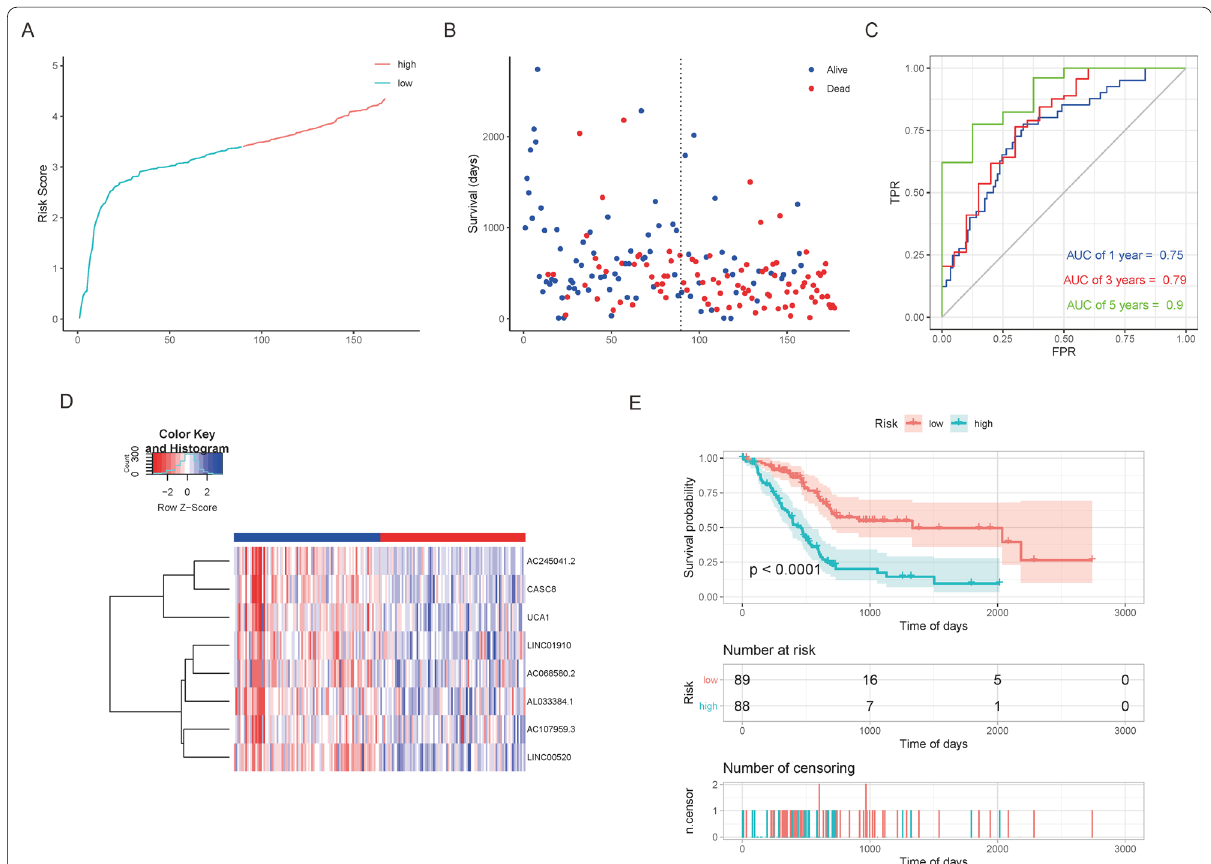
Fig. 7 The lncRNA prognostic risk model: A Sample risk score curve; B Scatter plot of sample survival time. Prior to the dotted line is the low-risk group sample, and the one after the dotted line is the high-risk group sample; C ROC curves presenting the predictive values of the prognostic risk model; D Heat map of gene expression in the model. Values are normalized with log10. The right longitudinal axis: the names of lncRNAs; the left longitudinal axis: the clustering information of the lncRNAs. The upregulated and downregulated mRNAs are depicted in red and blue, respectively; E KM curves for high and low-risk